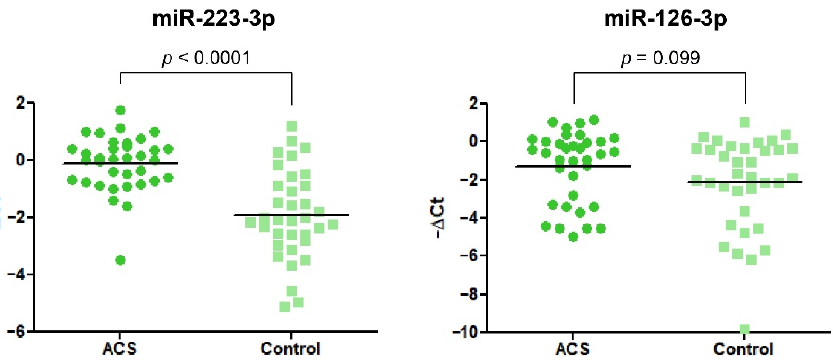
Figure 5. The relative expression of miR-223-3p and miR-126-3p in blood platelets of the study and control group. Data were calculated using a − ∆ Ct value with the means of both miR-191-3p and cel-miR-39-3p as reference miRNAs. Data are plotted as individual values with horizontal bars presenting the mean. The p -values reported above the graphs represent the results of Student’s t -tests or, in cases of unequal variance, Welch’s t